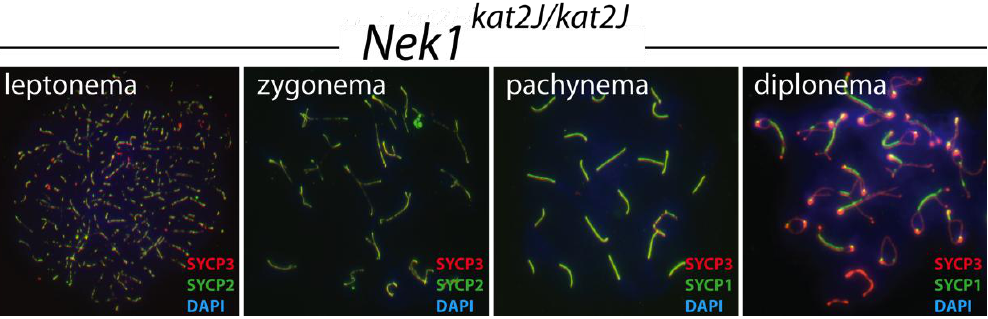
Figure 4. Nek1 kat2J/kat2J spermatocytes undergo normal synapsis. Wild type (not shown) and Nek1 kat2J/kat2J testes were stained with a variety of antibodies against meiotic prophase I proteins. Shown here is staining with SYCP3 (red), either SYCP1 or SYCP2 (green) and DAPI (blue) during the first four stages of prophase I; leptonema, zygonema, pachynema and diplonema.